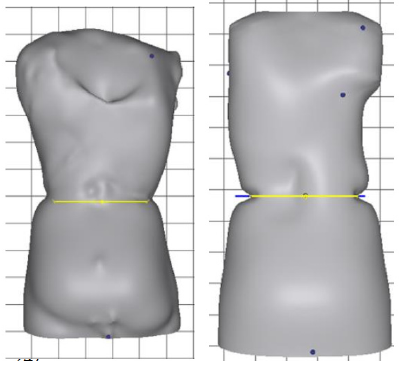
Figure 5. Modified scan for a Boston Brace 3D orthosis.